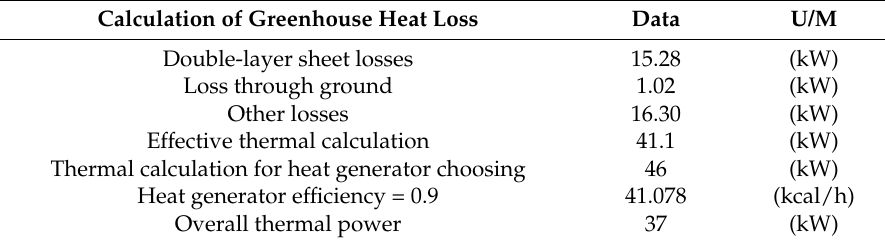
Table 2. Calculation of greenhouse heat